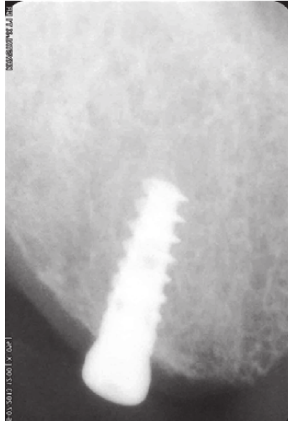
Figure 7: Intraoral periapical radiograph of implant after 4 months of osseointegration.